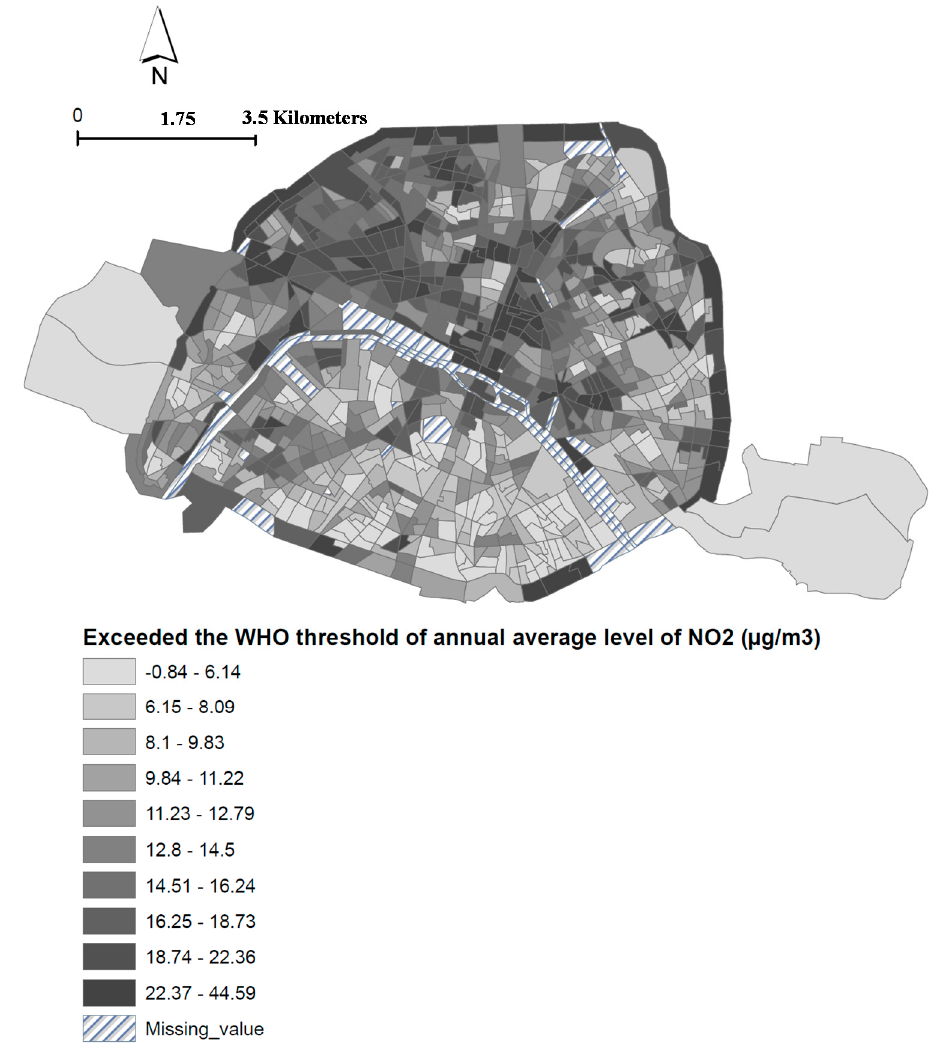
Figure A1. Spatial distribution of the exceeded the WHO threshold of annual average level of NO 2 from 2000–2009 (the difference between level of NO 2 exposure in each census block and WHO guidelines (40 μ g/m 3 ))